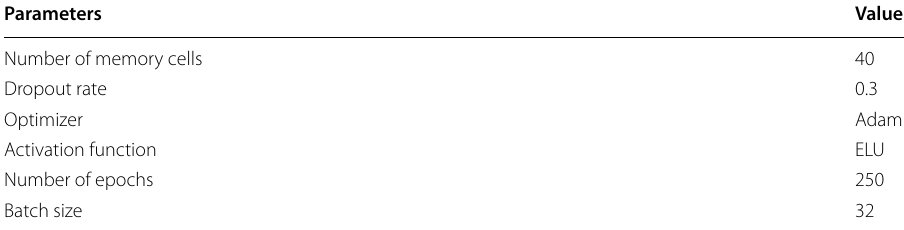
Table 4 Parameters of LSTM network